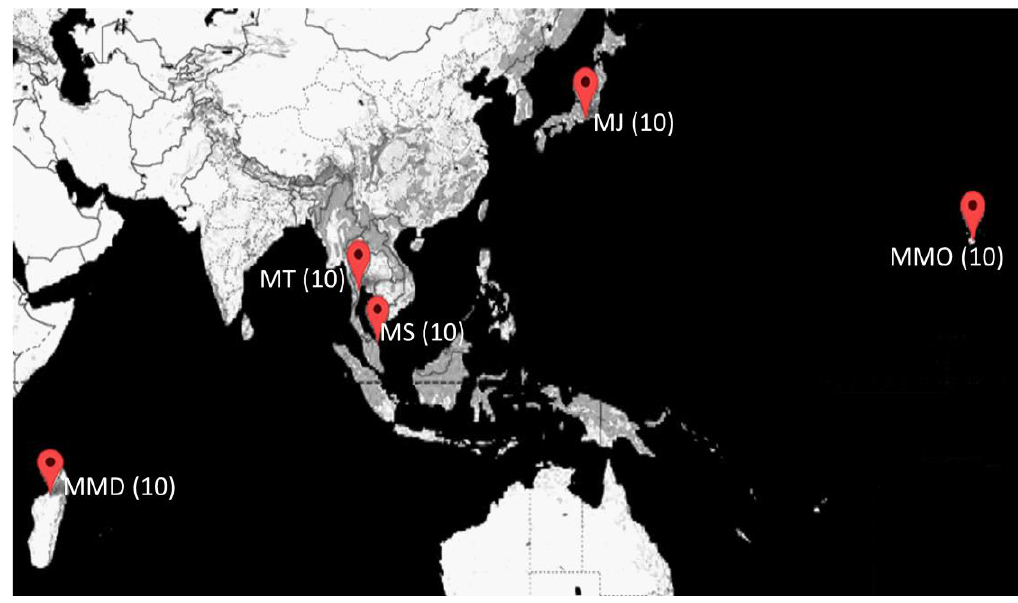
Figure 1. Sampling sites of five broodstock populations of Penaeus monodon in the Indo-Pacific region. MMD (Madagascar), MT (Thailand) and MMO (Hawaii, HI, USA) represent domesticated populations, while MS (Malaysia) and MJ (Japan) are wild-caught populations. Values in parentheses denote the sample size for each population.